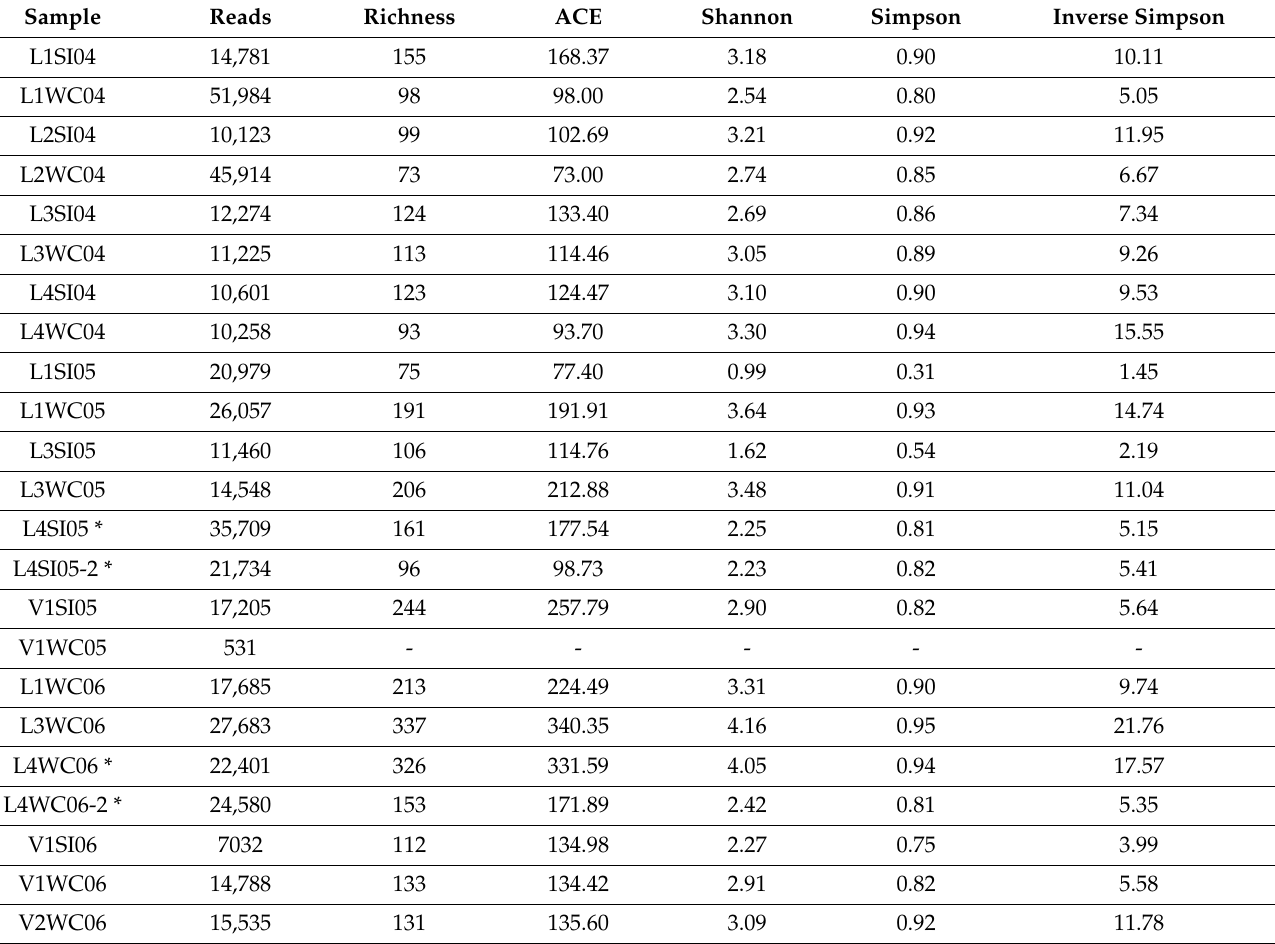
Summary NGS-data statistics and alpha-diversity indices of LL and LV